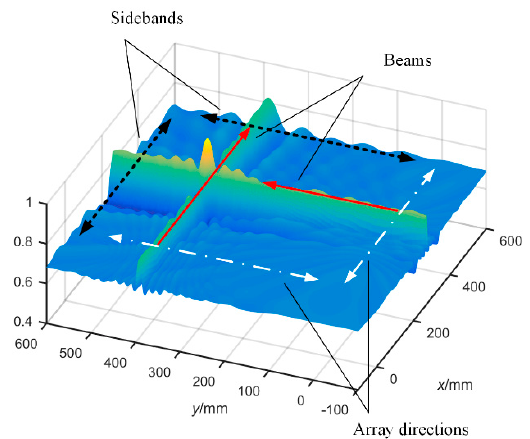
Figure 7. The three-dimension beamforming output diagram of a set of simulated signals.